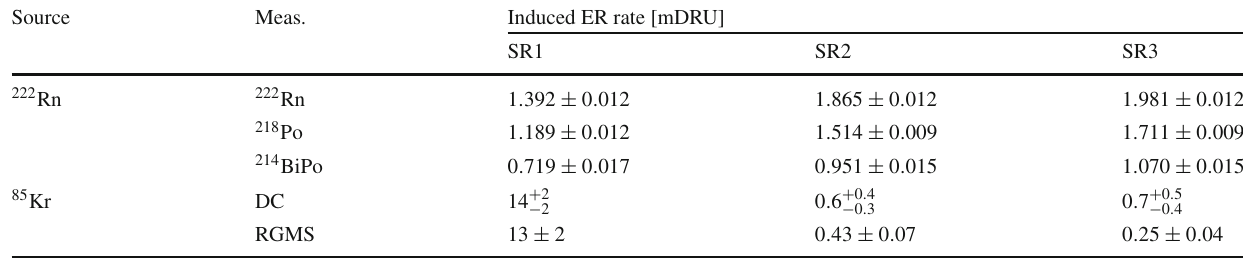
Table4 EstimatesfortheaverageERbackgroundinducedbythe 222 Rn chain and 85 Kr (below 100keV, before applying ER/NR discrimina- tion). Values are inferred from different measurements. Only